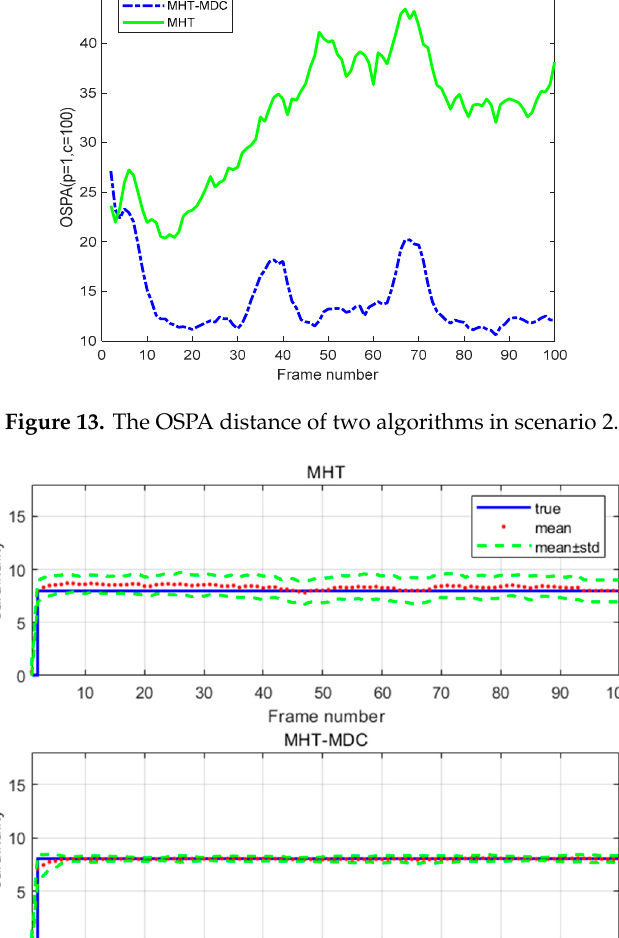
Figure 12. The estimated trajectories of the MHT in scenario 2.